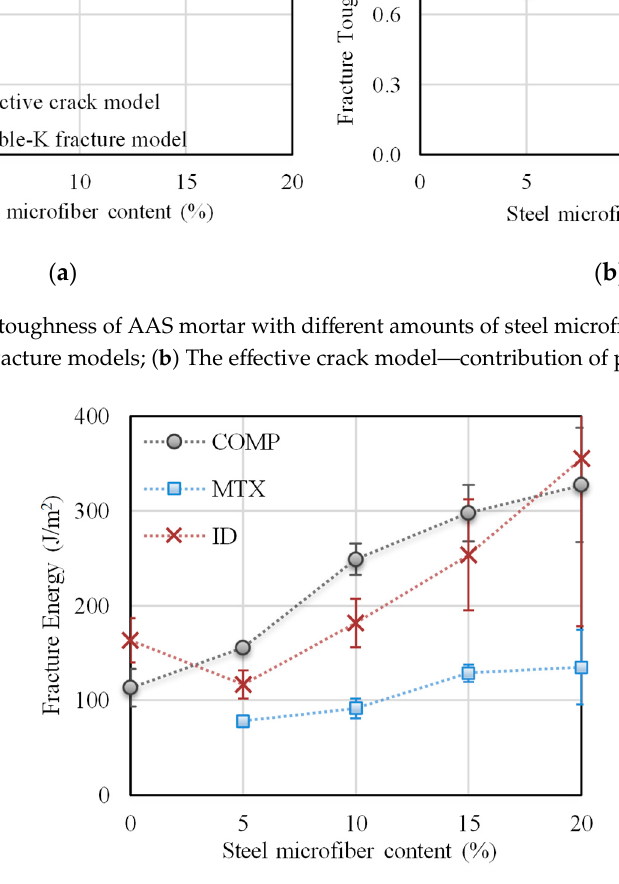
Figure 9. Fracture energy of AAS mortar with different amounts of steel microfibers.